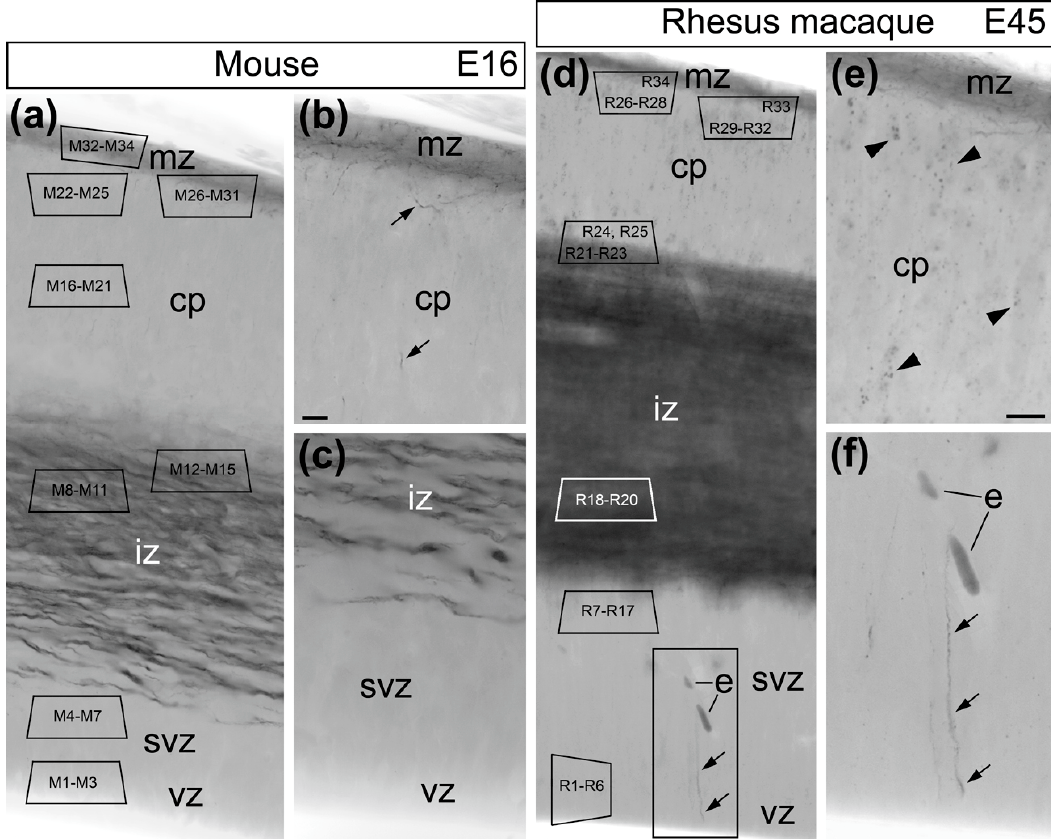
Figure 5. CB 1 R-L31 immunolabeling in the cerebral cortex of E16 mouse ( a – c ) and E45 rhesus macaque embryos ( d – f ). Abundant immunoperoxidase reaction end-product in the intermediate zones (IZs) of the mouse and monkey are mostly due to CB 1 R-positive axons, whereas marginal zones (MZs) contain numerous CB 1 R-positive cell bodies of tangentially migrating interneurons [23,24]. ( b ) Mouse cortical plate (CP) does not demonstrate CB 1 R accumulation with exception of rare CB 1 R-positive processes (arrows). ( e ) Numerous CB 1 R-positive globules are detectable in the monkey cortical plate (arrowheads). ( c , f ) Ventricular (VZ) and subventricular zones (SVZs) are mostly CB 1 R-immunonegative in both animals with exception of rare radial processes (arrows). Area framed with rectangle in ( d ) is enlarged in ( f ). Indexes M1-M34 and R1-R34 inside trapezoid frames in ( a ) and ( d ) schematically indicate positions of 3D reconstructed cells (see below). Abbreviation: e, erythrocytes in blood capillary. Scale bars: ( a , d ) 100 μ m m and ( b , c , e , f ) 10 μ m.